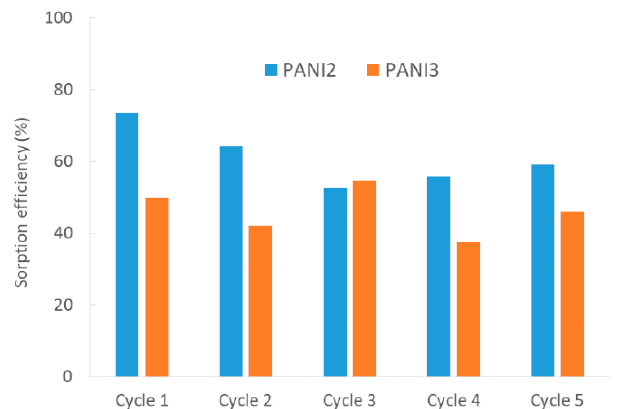
Figure 8. Percentage of sorption e ffi ciency towards MOs for PANI2 and PANI3 under 5-run recycling (cycles 1–5).